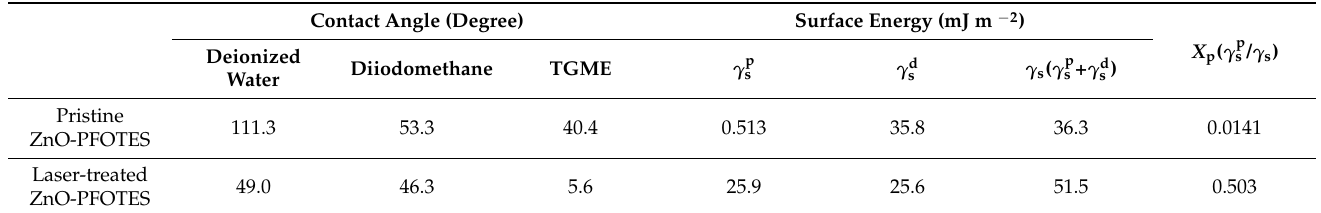
Table 1. Surface energy characteristics of pristine and laser-treated ZnO-PEOTES coatings.